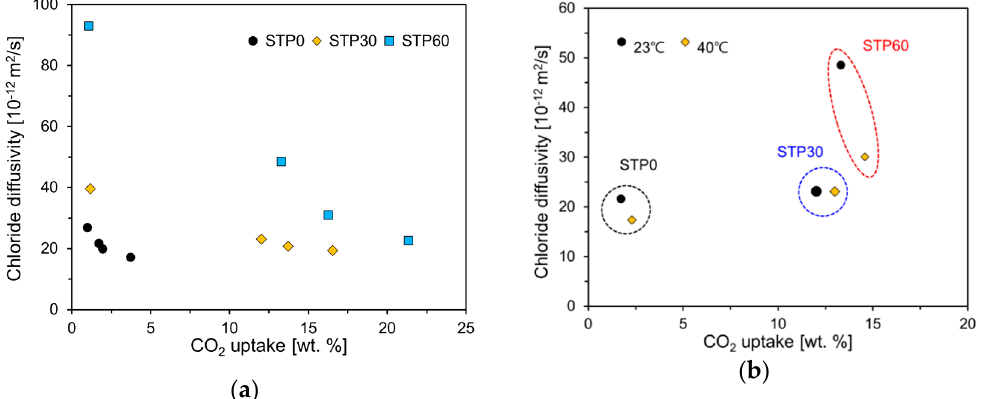
Figure 13. Comparison between CO 2 uptake and chloride diffusivity: ( a ) CO 2 concentration and ( b ) curing temperature.